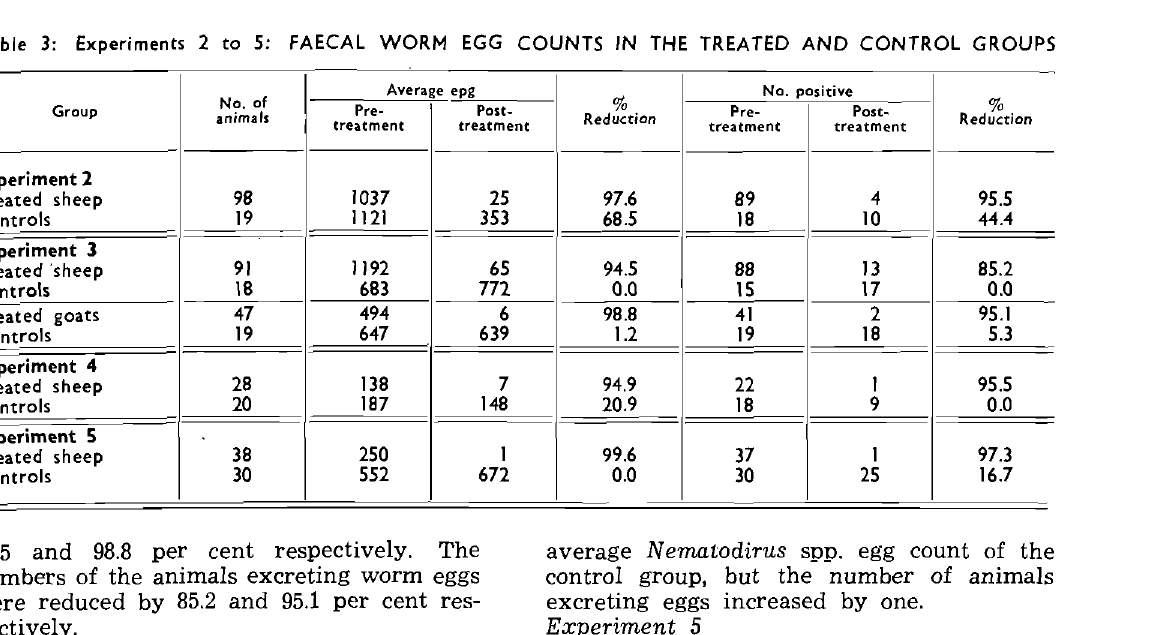
INFESTED FLOCKS Average epg and percentage of sheep positive during